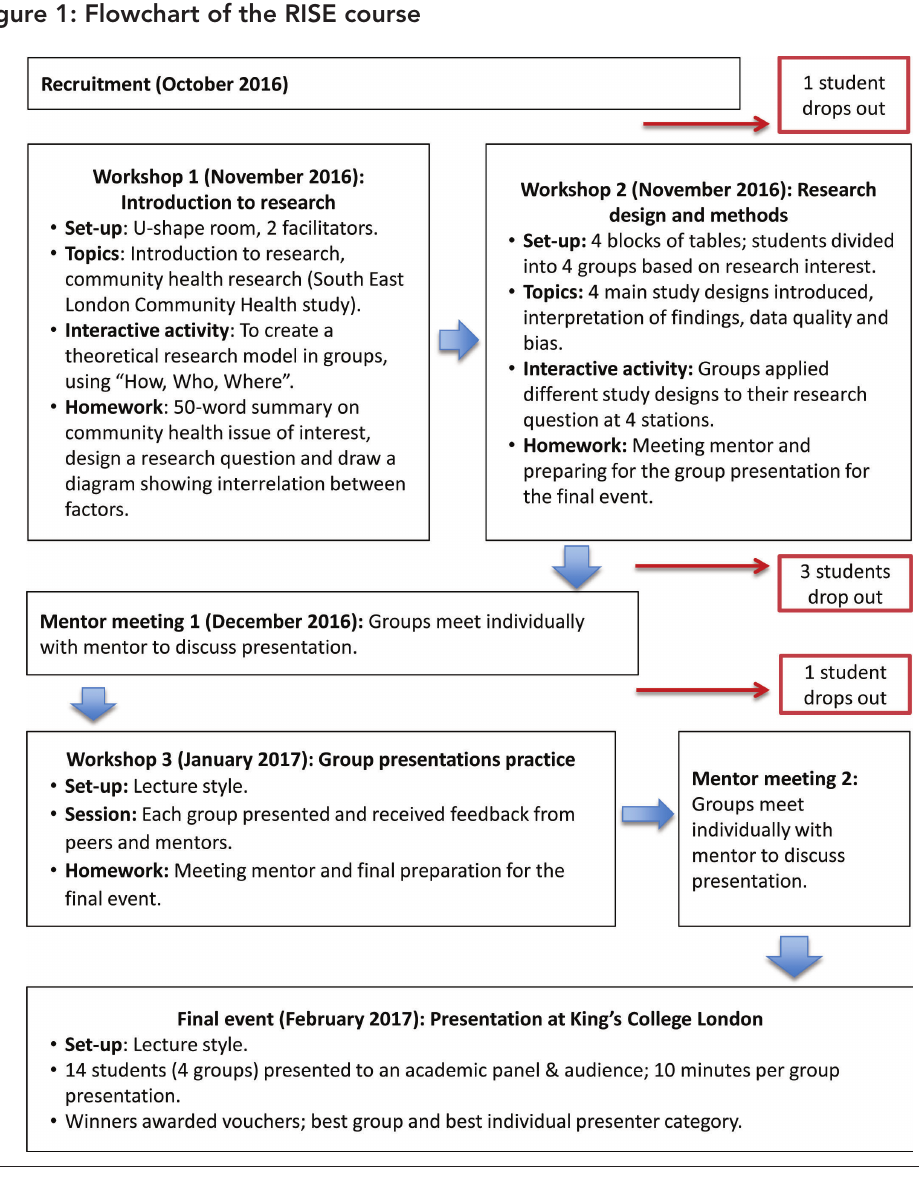
Figure 1: Flowchart of the RISE